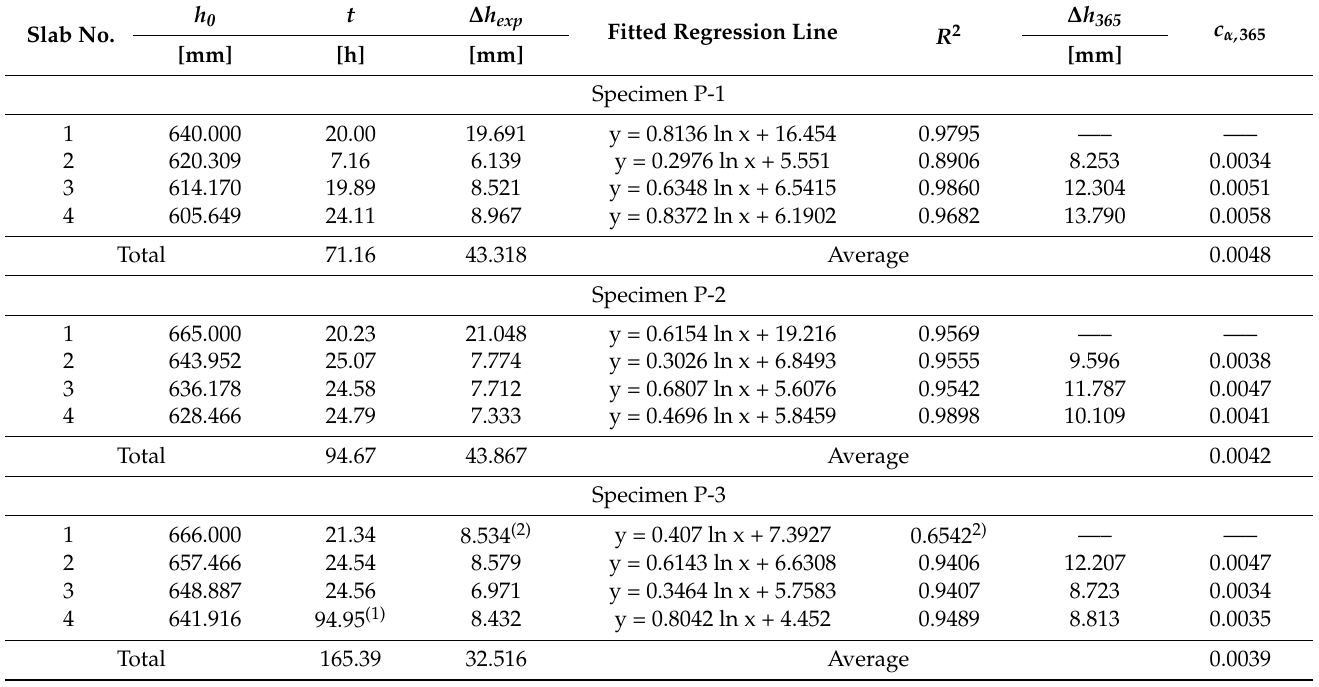
Table 7. Creep test